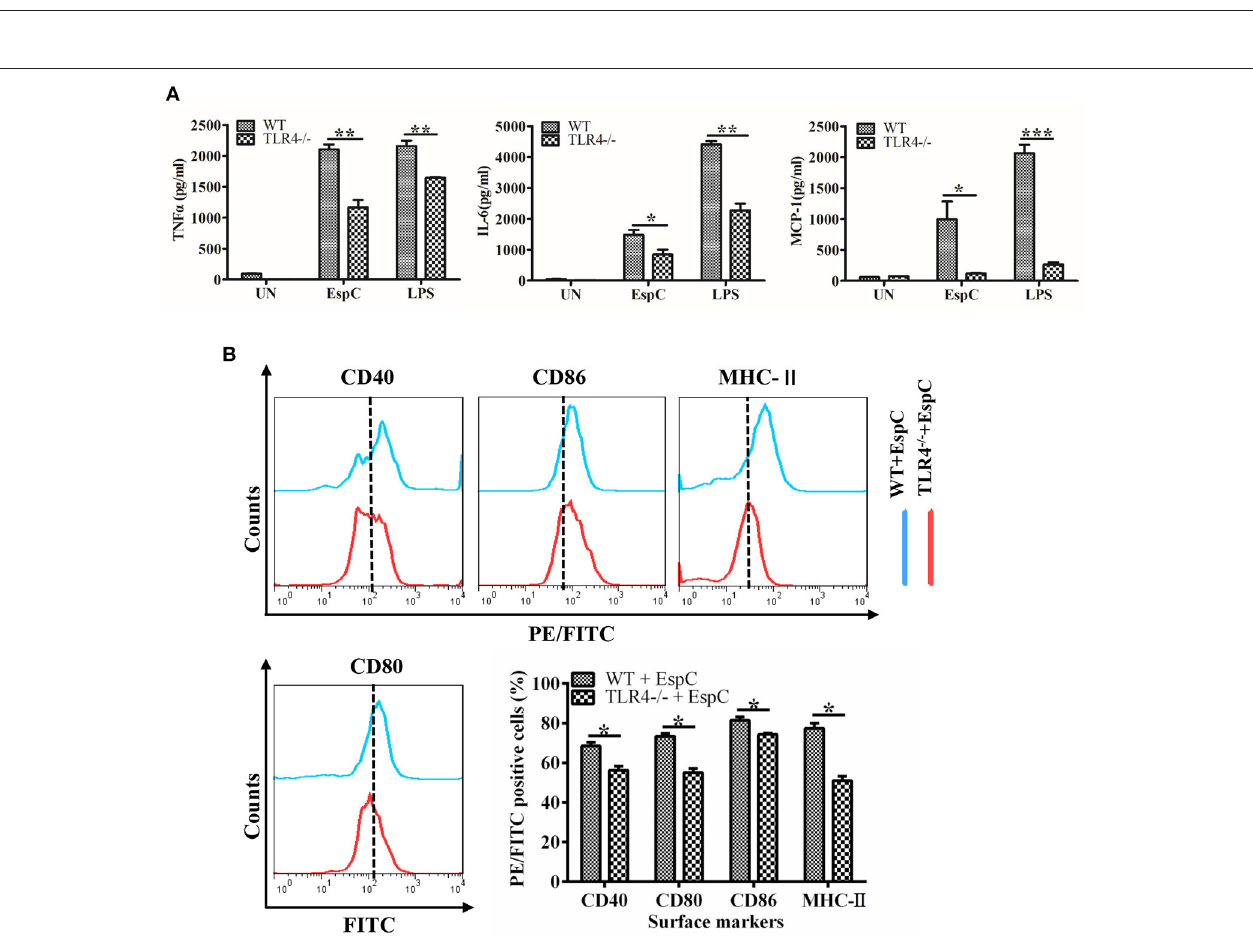
FIGURE 3 | EspC enhanced the expression of pro-inflammatory cytokines and costimulatory and MHC molecules on macrophages in a TLR4-dependent manner. (A) TNF- α , IL-6, and MCP-1 production in macrophages derived from TLR4 − / − mice or C57BL/6 mice after treatment with medium alone, EspC (5 µ g/mL), or LPS (1 µ g/mL). Cytokine levels were measured by ELISA. (B) Macrophages from C57BL/6 mice and TLR4 − / − mice were treated with EspC (5 µ g/mL) for 24h and were analyzed to determine the expression of surface markers by flow cytometry. FACS analysis was repeated three times, and all samples were run in duplicate. Data are shown as means ± SEMs ( n = 3); * p < 0.05, ** p < 0.01, *** p <